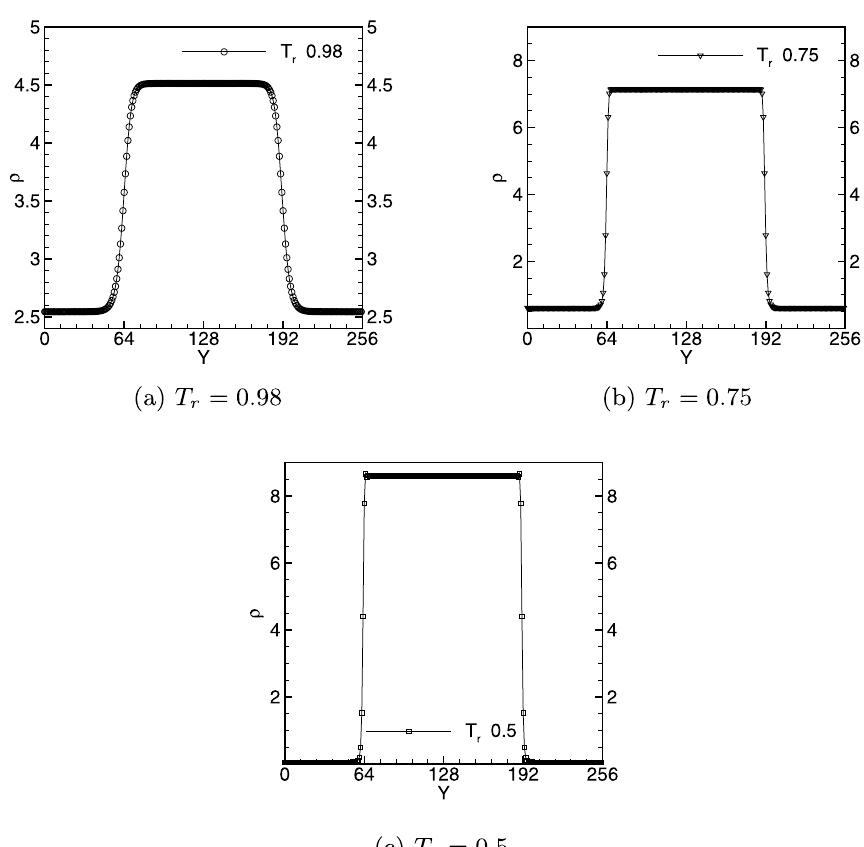
Fig. 3 Density profile produced by DUGKS with varying temperatures, τ =